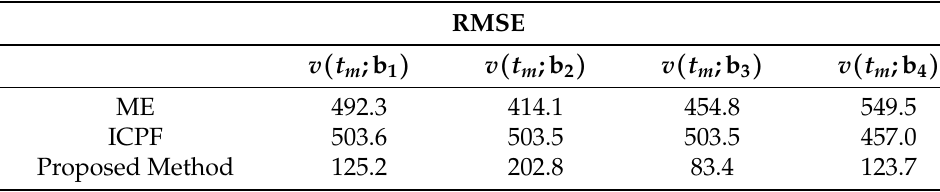
Table 6. Estimated speed RMSE of different algorithms using TG-I EM simulation